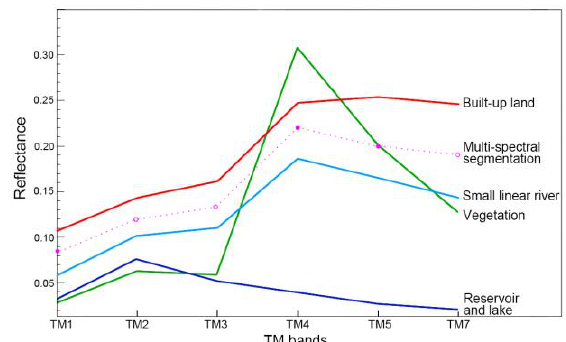
Figure 5. Comparison of the spectral characteristics of typical objects (reservoir and lake, vegetation, small linear river, built- up land) with the proposed multi-spectral segmentation and its potential to better separate built-up land and small linear rivers Further analysis has been made on the sample data of small linear river with pixel 2080  n and sample data of built-up land with pixel 2287 m  on each band among the six